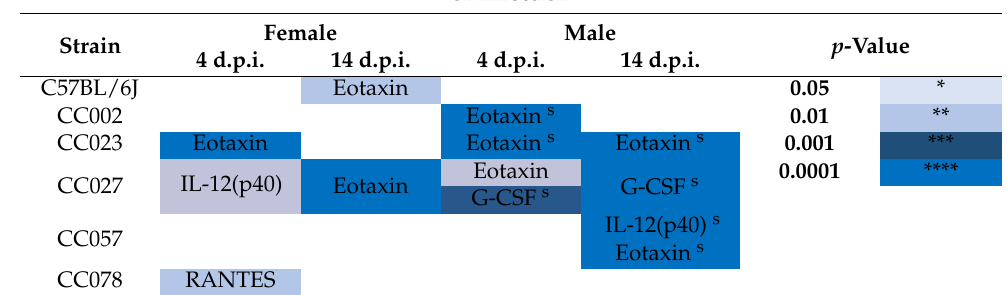
Table 4. Certain cyto/chemokine levels in control vs. infected mice were significantly different for females and males of different strains. Cells are highlighted according to the p -value of significance.